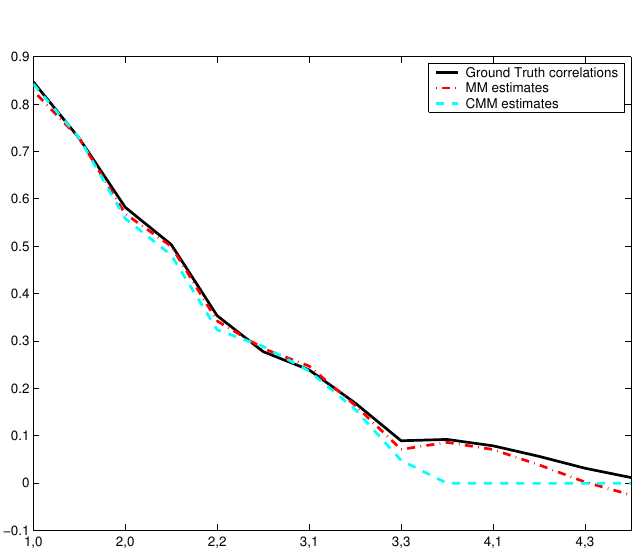
Figure 5 – Mean correlation measures under the strong dependency case for the classical (MM) and the corrected (CMM) Method-of-Moments